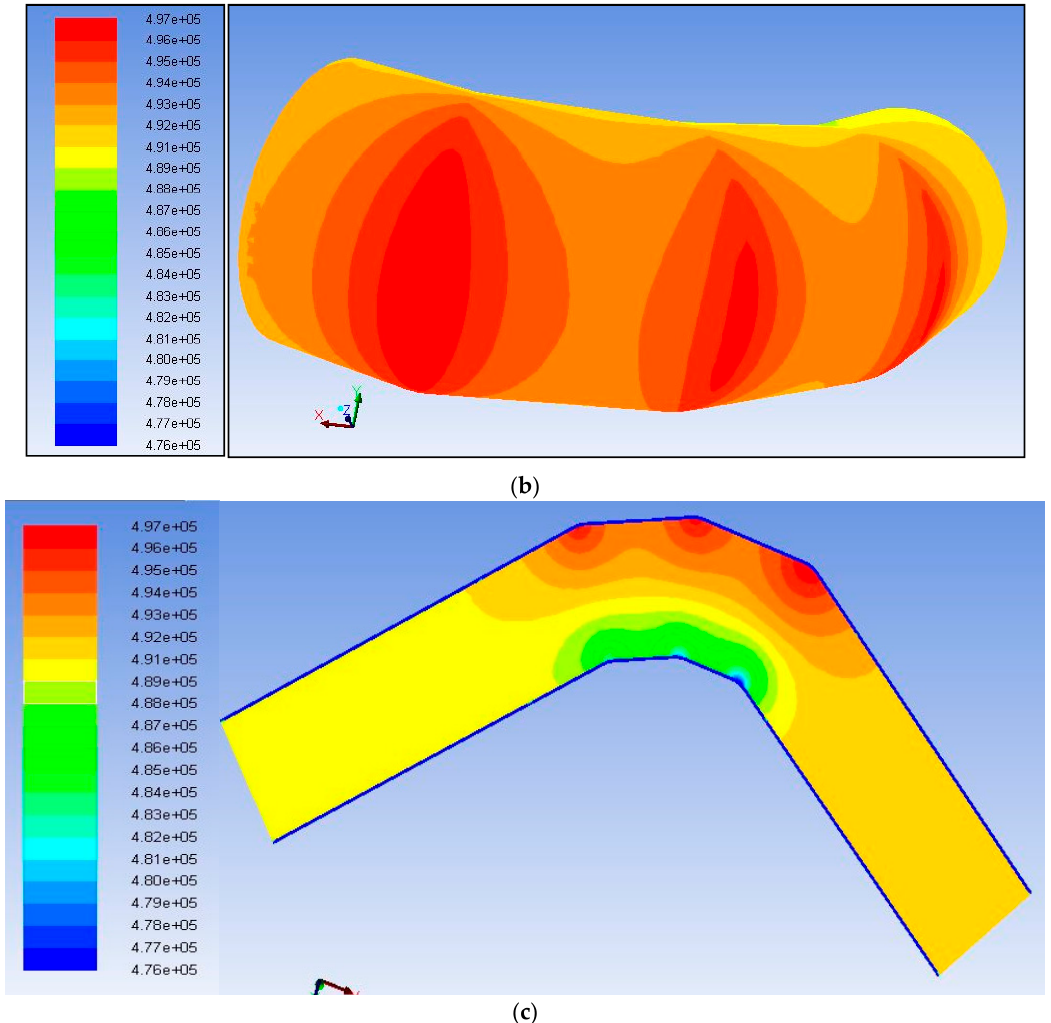
Figure 18. Contours of pressure obtained from CFD analysis.